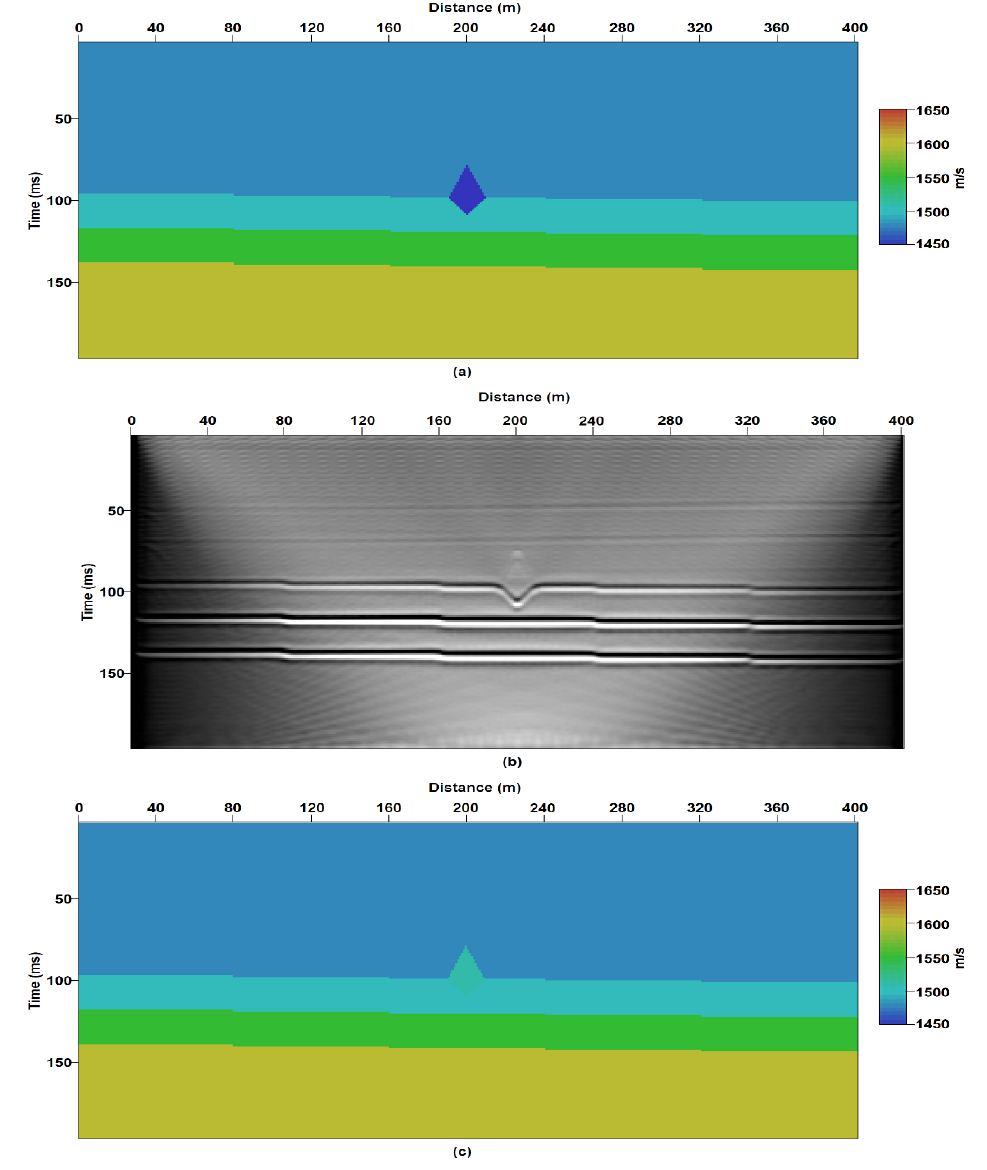
Figure 6. Numerical imaging results: ( a ) input velocity model of the negative acoustic variant with the flat model; ( b ) RTM image of ( a ); ( c ) input velocity model of the positive acoustic variant with the flat model; ( d ) RTM image of ( c